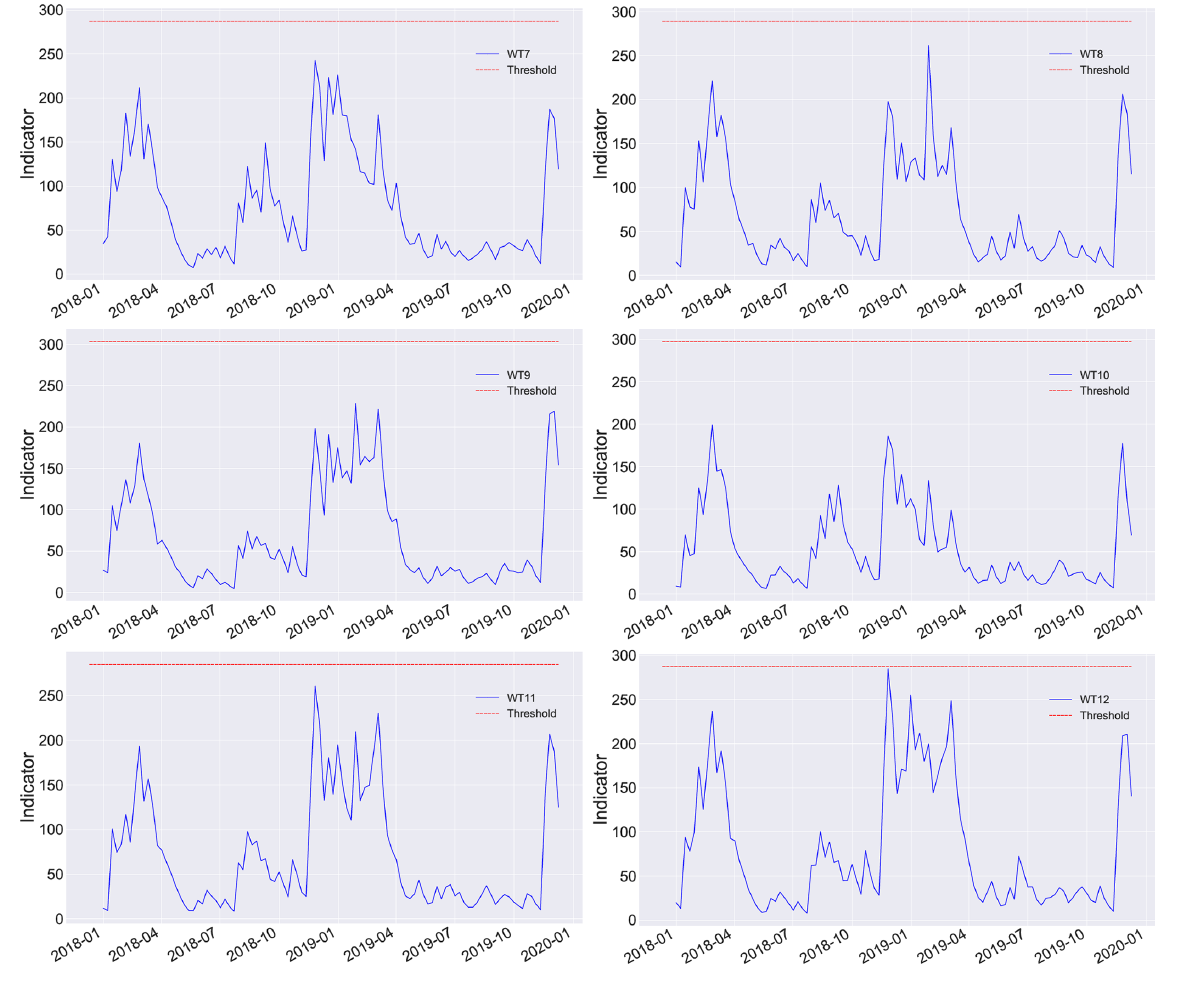
Figure 11. Weekly indicator